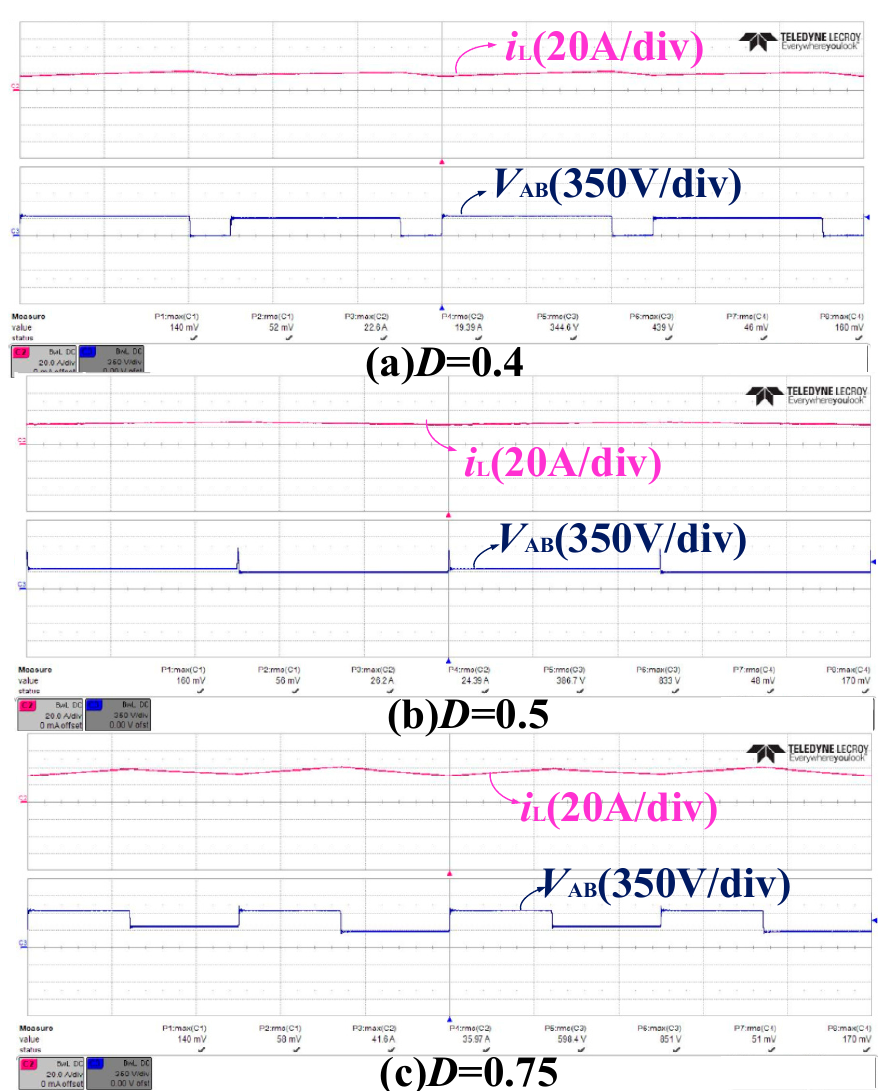
Figure 19. Experimental results of the front-end three-level buck converter ( a ) D = 0.4; ( b ) D = 0.5; ( c ) D = 0.75.